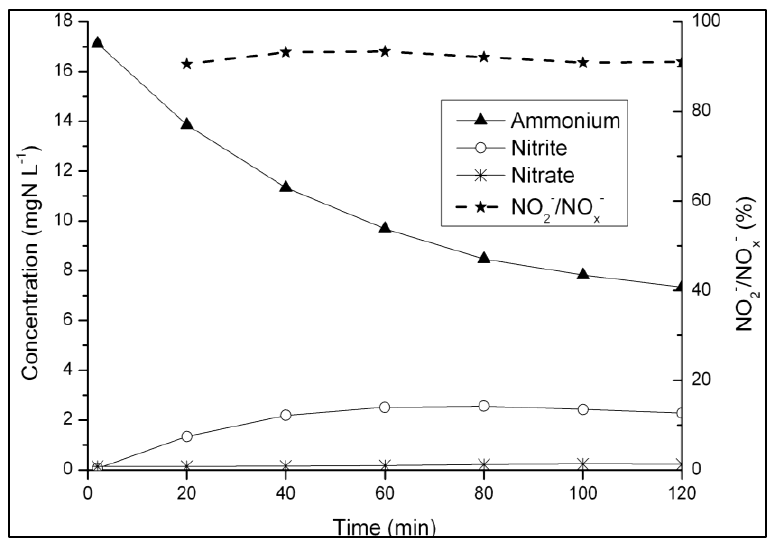
Figure 5. Nitrification batch test with granular sludge taken at the end of the starvation phase without COD supply (at day